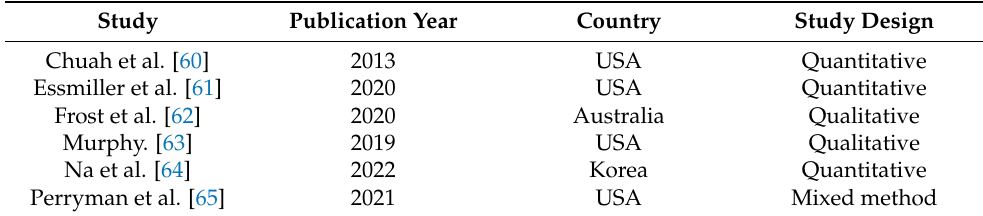
Table 1. General characteristics of included studies (n = 6).